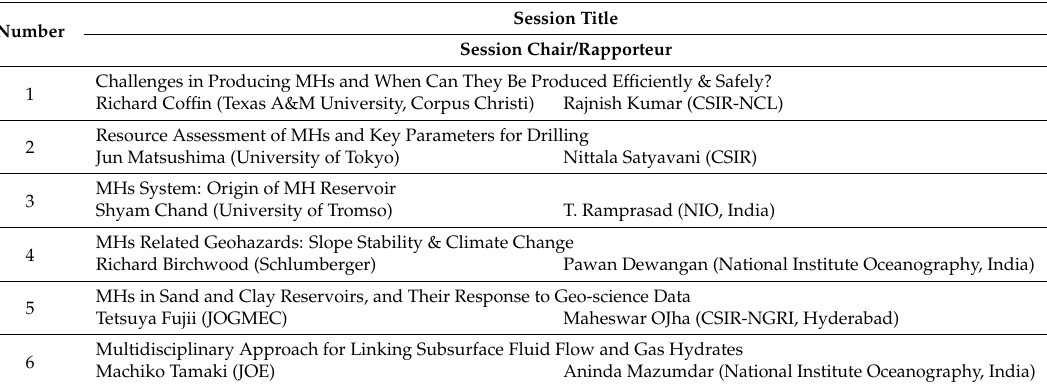
Table 10. Breakout sessions (title and